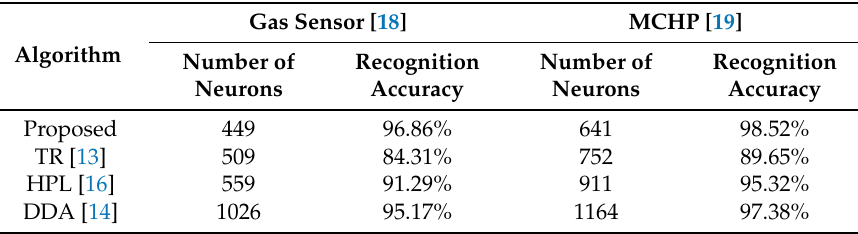
Table 1. Performance evaluation results ( θ = 5, γ = 10).